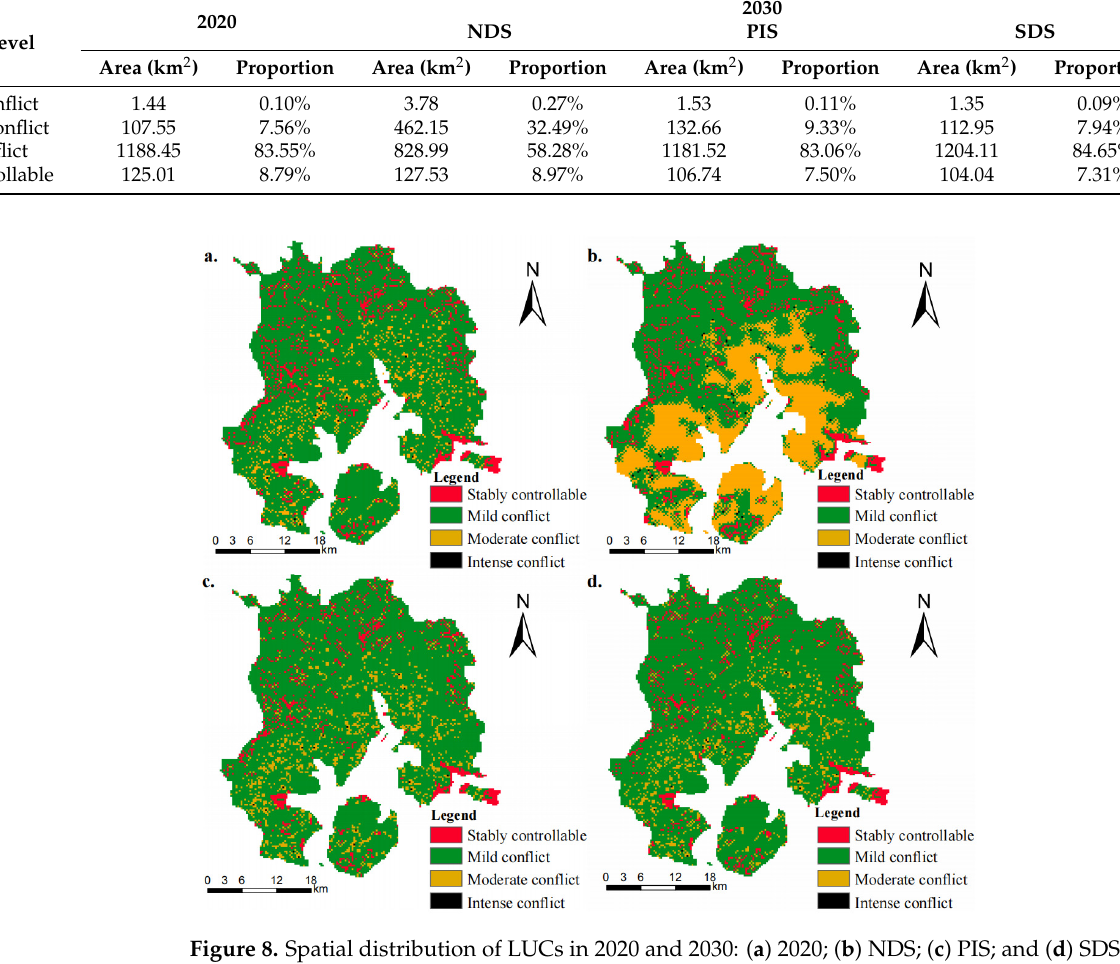
Figure 8. Spatial distribution of LUCs in 2020 and 2030: ( a ) 2020; ( b ) NDS; ( c ) PIS; and ( d ) SDS.